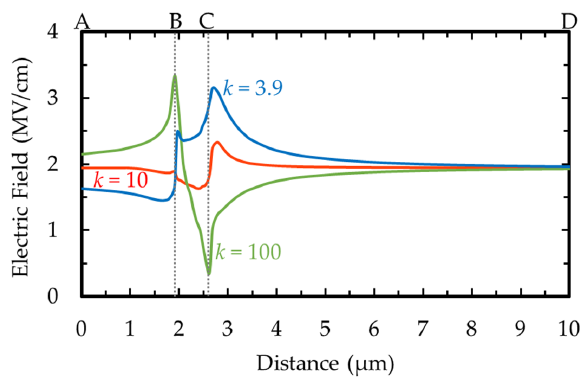
Figure 3. Electric field along the mesa and peripheral from point A to point D. Electronics 2016 , 5 , 15